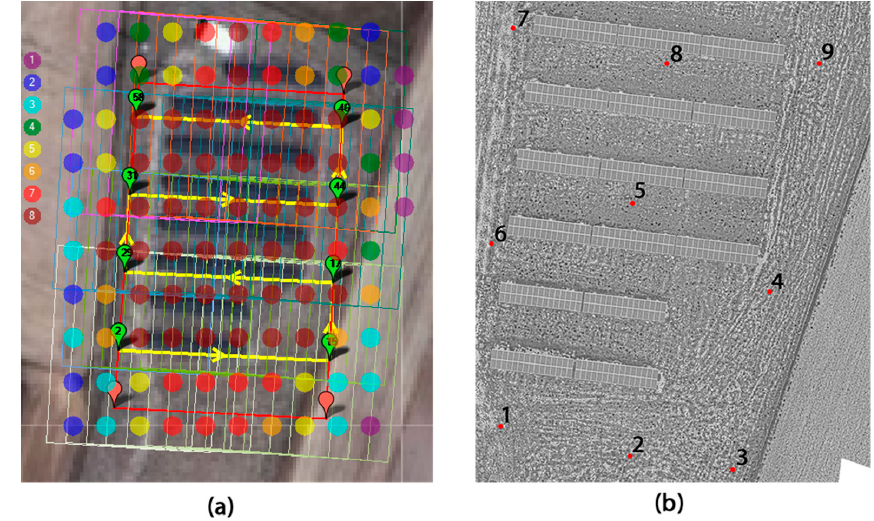
Figure 7. ( a ) Flight planning designed for acquisition of RGB imagery according to the requisites. Yellow lines represent the flight path. Green labels represent way points. Color points represent image redundancy through overlapping. In particular, the number of images with overlap are indicated in the legend with a number at the left of the image. ( b ) GCP (Ground Control Points) homogeneously distributed over the whole study area.